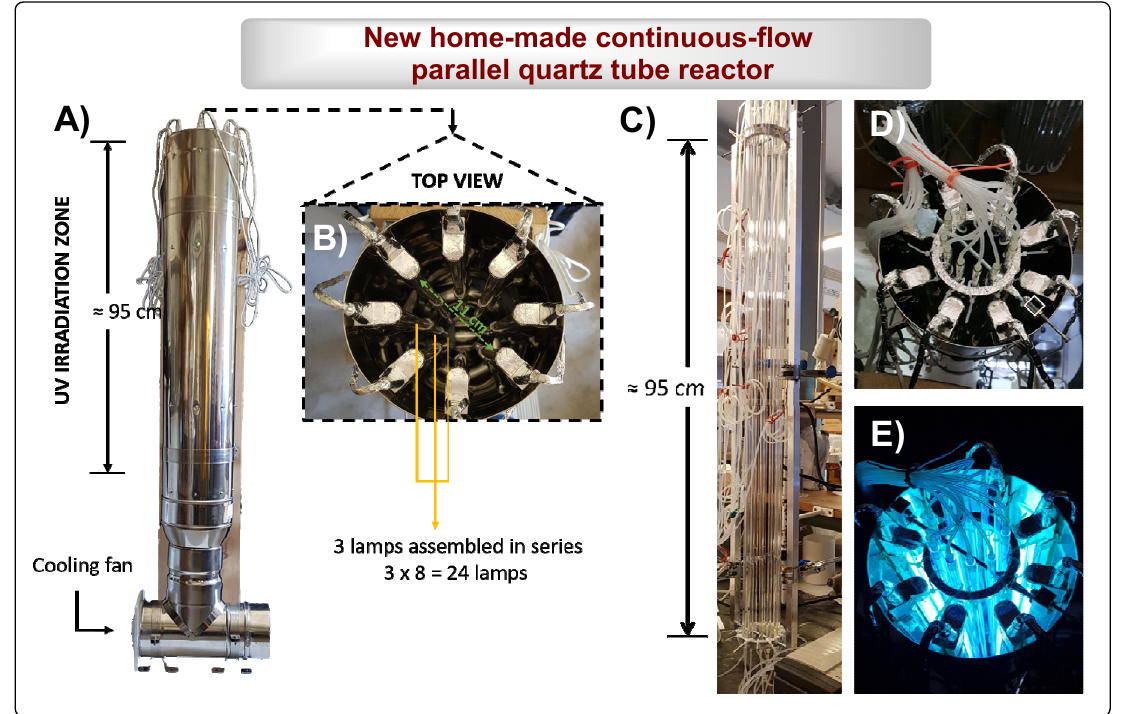
Figure 2. New home-made UV reactor and continuous-flow parallel quartz tube reactor. ( A ) Overview of the new home-made UV reactor; ( B ) UV reactor top-view; ( C ) 12 assembled parallel quartz tubes reactor (PQT6); ( D ) Reactors top-view; ( E ) Top-view of the reactors under photochemical irradiation.